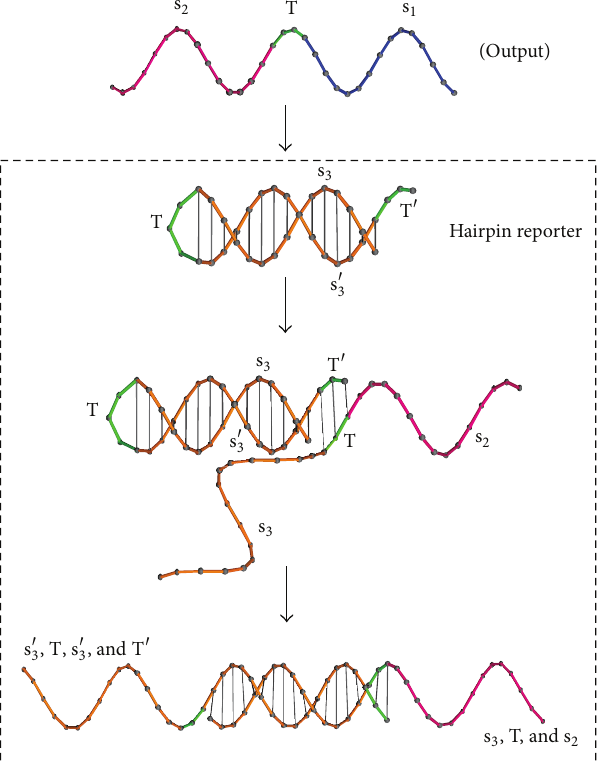
Figure 2: Reporter strand with “hairpin” to detect whether Output strands are being released.